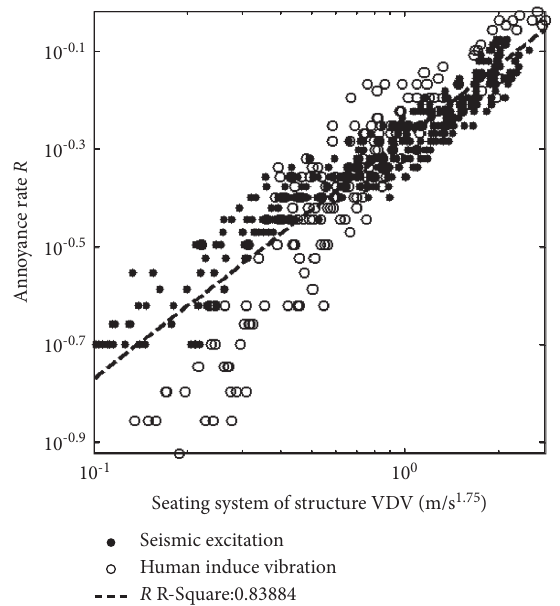
Figure 11: The distribution of crowds annoyance rate of